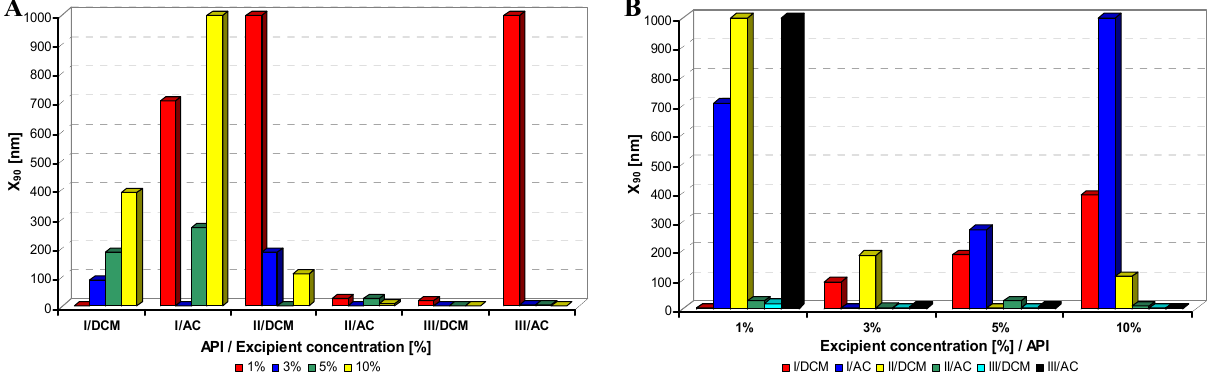
Figure 4. Dependence of particle size (x [nm]) of model APIs I – III on concentration [%] 90 of macrogol 6000 in dichloromethane (DCM) or acetone (AC). ( A ) Samples are grouped according to APIs; ( B ) samples are grouped according to excipient percentage. For clarity sake, the values on y-axis are only to 1,000 nm.